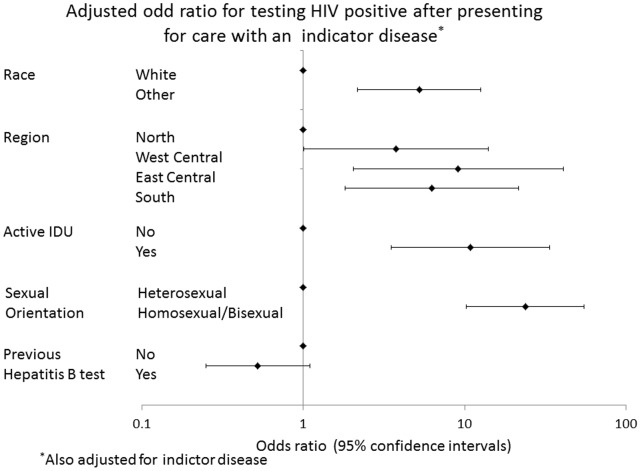
Odd ratio for testing HIV positive.